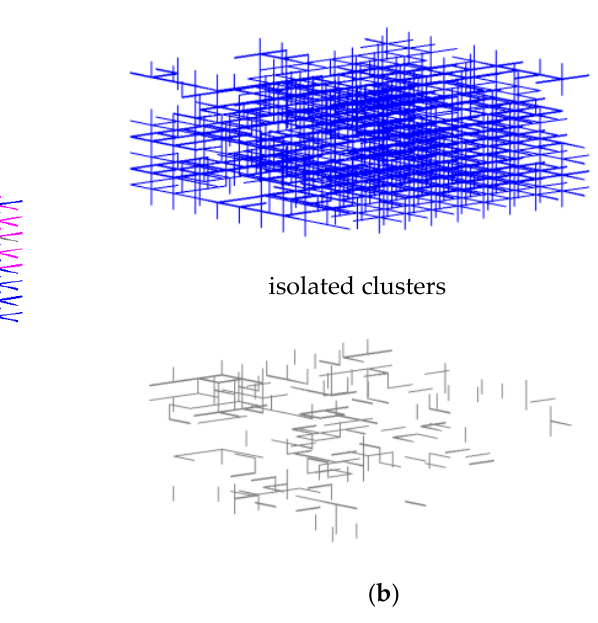
Figure 3. Liquid clustering in a 3-dimensional (3D) PN on the example of a small 10 × 10 × 10 network with homogeneous PSD and the parameters specified in Table 1. The transport barrier clusters (isolated and discrete) are shown in grey ( a , b ); the liquid transporting clusters are shown in blue ( a , b ); and the continuous gas phase is shown in magenta ( a ). Pores are not shown for reasons of readability.